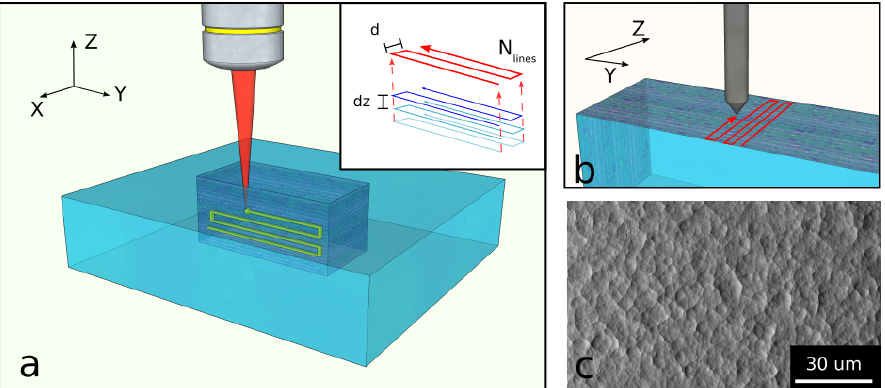
Figure 4. Schemes of the surface fabrication and analysis: ( a ) laser irradiation pattern geometry; ( b ) stylus profilometer raster scan analysis; ( c ) SEM image of a FLICE (femtosecond laser irradiation followed by chemical etching) machined surface.